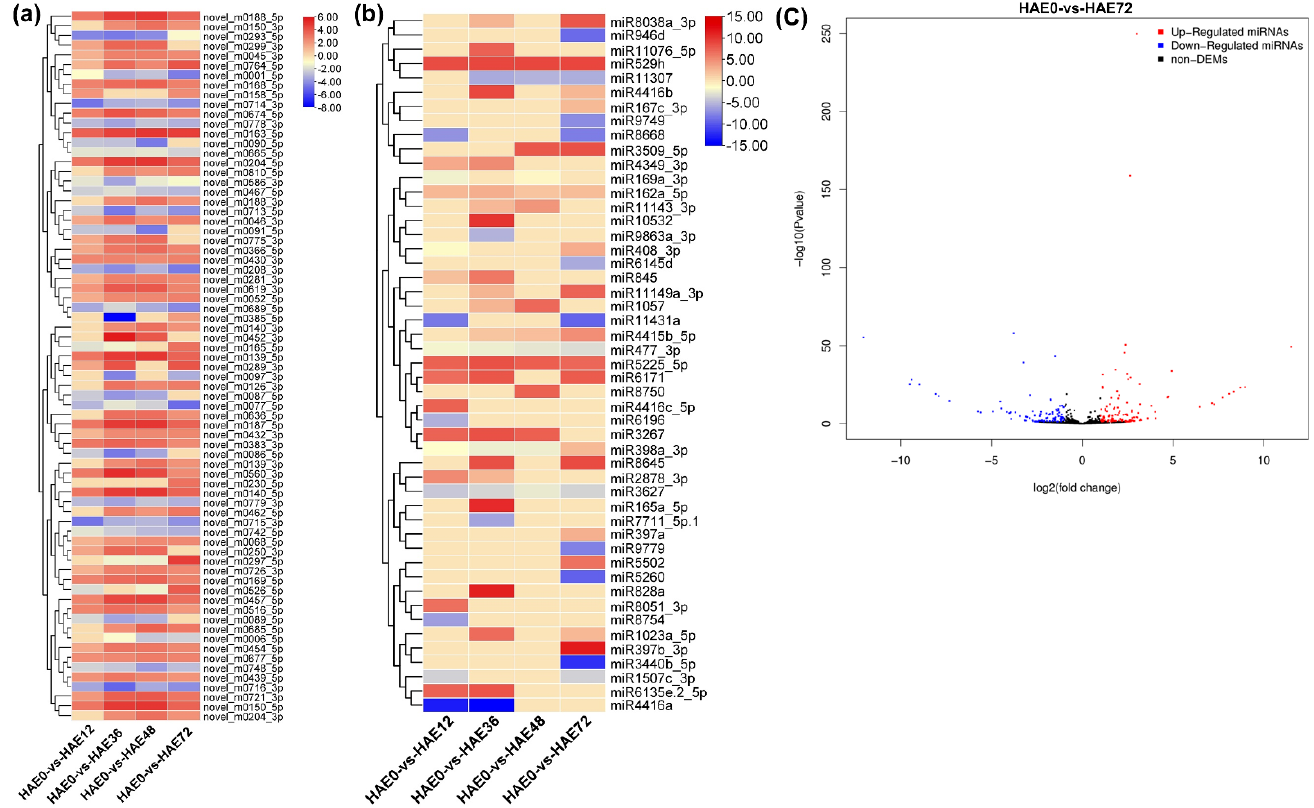
Figure 4. Hierarchical clustering of differentially expressed miRNAs in dark-pretreated tetraploid R. pseudoacacia L. during IBA-dependent AR formation. ( a ) Heatmap showing the number of the known differentially expressed upregulated and downregulated miRNAs in the four comparison groups. ( b ) Heatmap showing the expression pattern of the novel differentially upregulated and downregulated miRNAs. ( c ) A volcano plot showing the DE miRNAs in the HAE0-vs-HAE72 comparison group libraries. The clusters were generated based on the Pearson correlation coefficient of normalized miRNA expression values. Bars indicate log2 (TPM + 1) values.